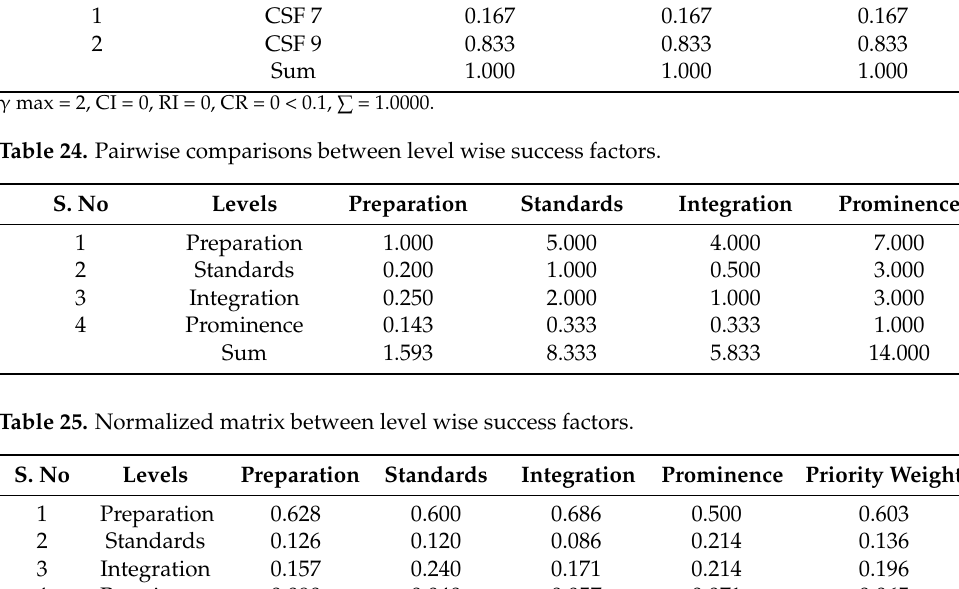
Table 23. Normalized matrix for prominence level success factors. S. No